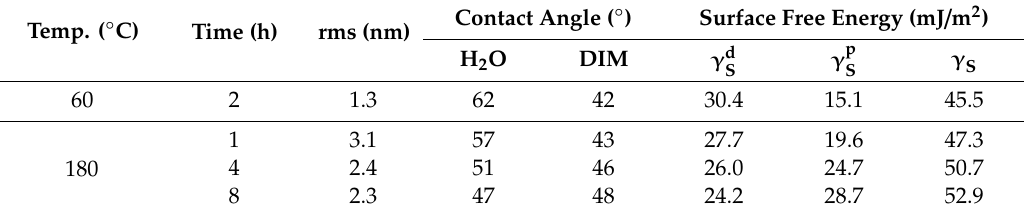
Table 3. Root-mean-square surface roughness, advancing contact angles for water and diiodomethane, and surface free energies of poly(vinyl phenol) prepared in ethyl-3-ethoxypropionate (PVPH-E). Contact Angle ( ◦ Temp. ( ◦ C) Time (h) rms (nm)